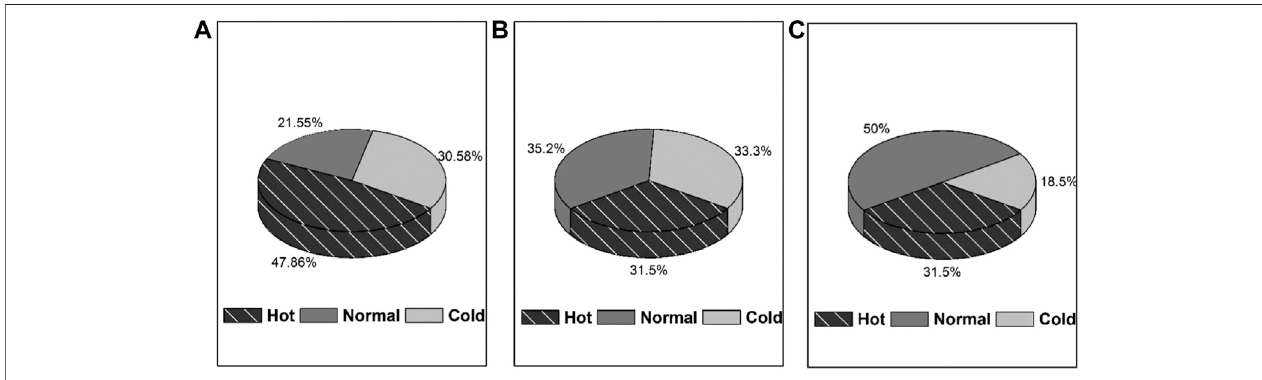
FIGURE 5 | Temperature variation (Hot condition) (Normal condition) and (Cold condition) in (A) R1, (B) R2 and (C) R3 based on the period of 1961 – 2014.